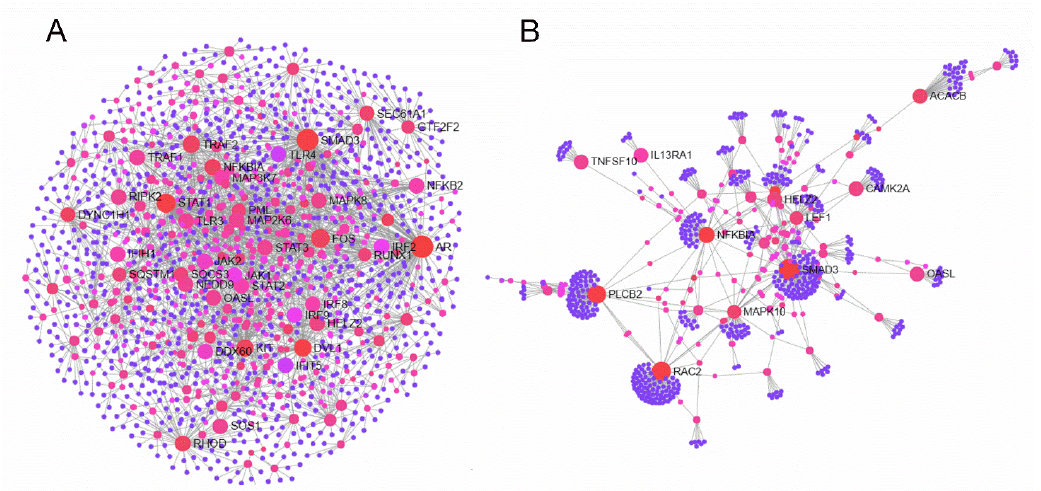
Figure 4. Network analysis of DEGs. NetworkAnalyst was used to construct the protein–protein network of DEGs in chMDA5 ( A ) and poly(I:C) ( B ) group based on STRING database. Nodes that connect to at least two other nodes are labeled with different red colors.